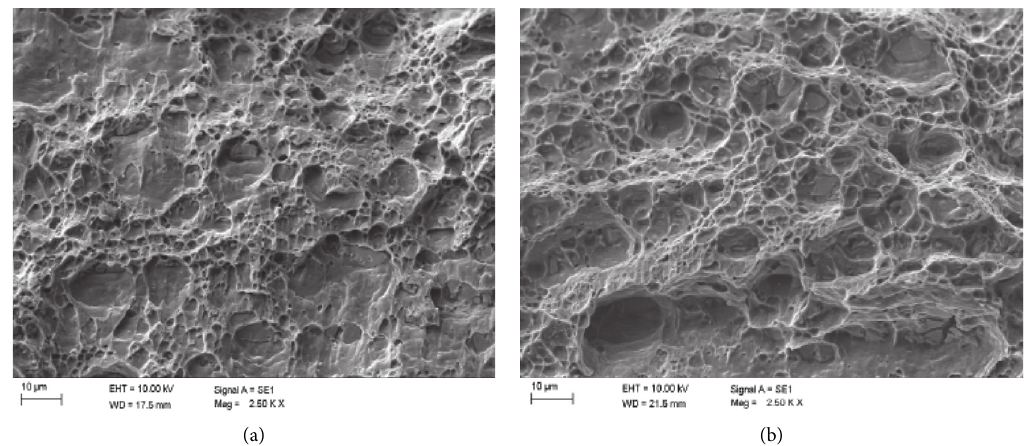
Figure 14: SEM micrograph of fractured specimen for exp nos. (a) 4 and (b) 17.